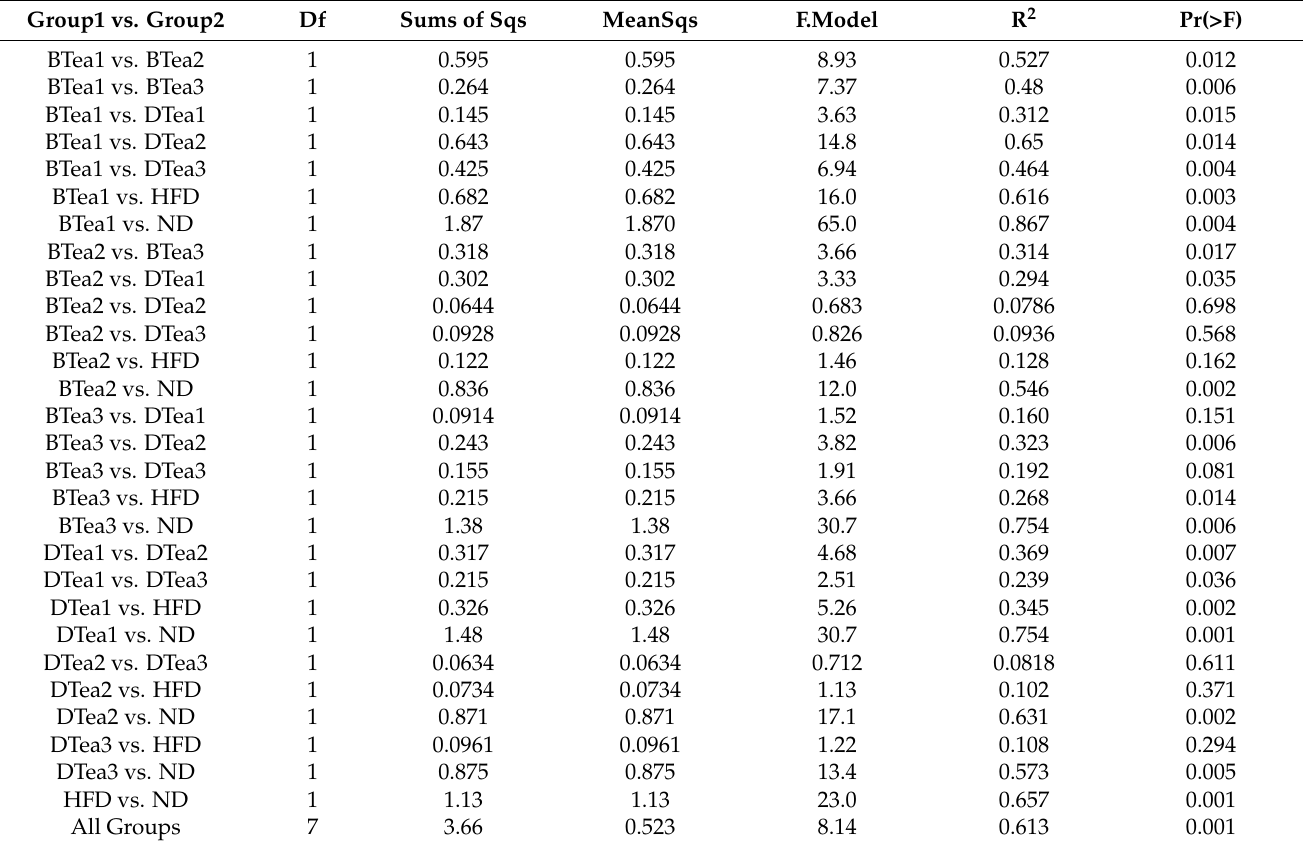
Table 3. Effect of different black and dark teas on gut microbial